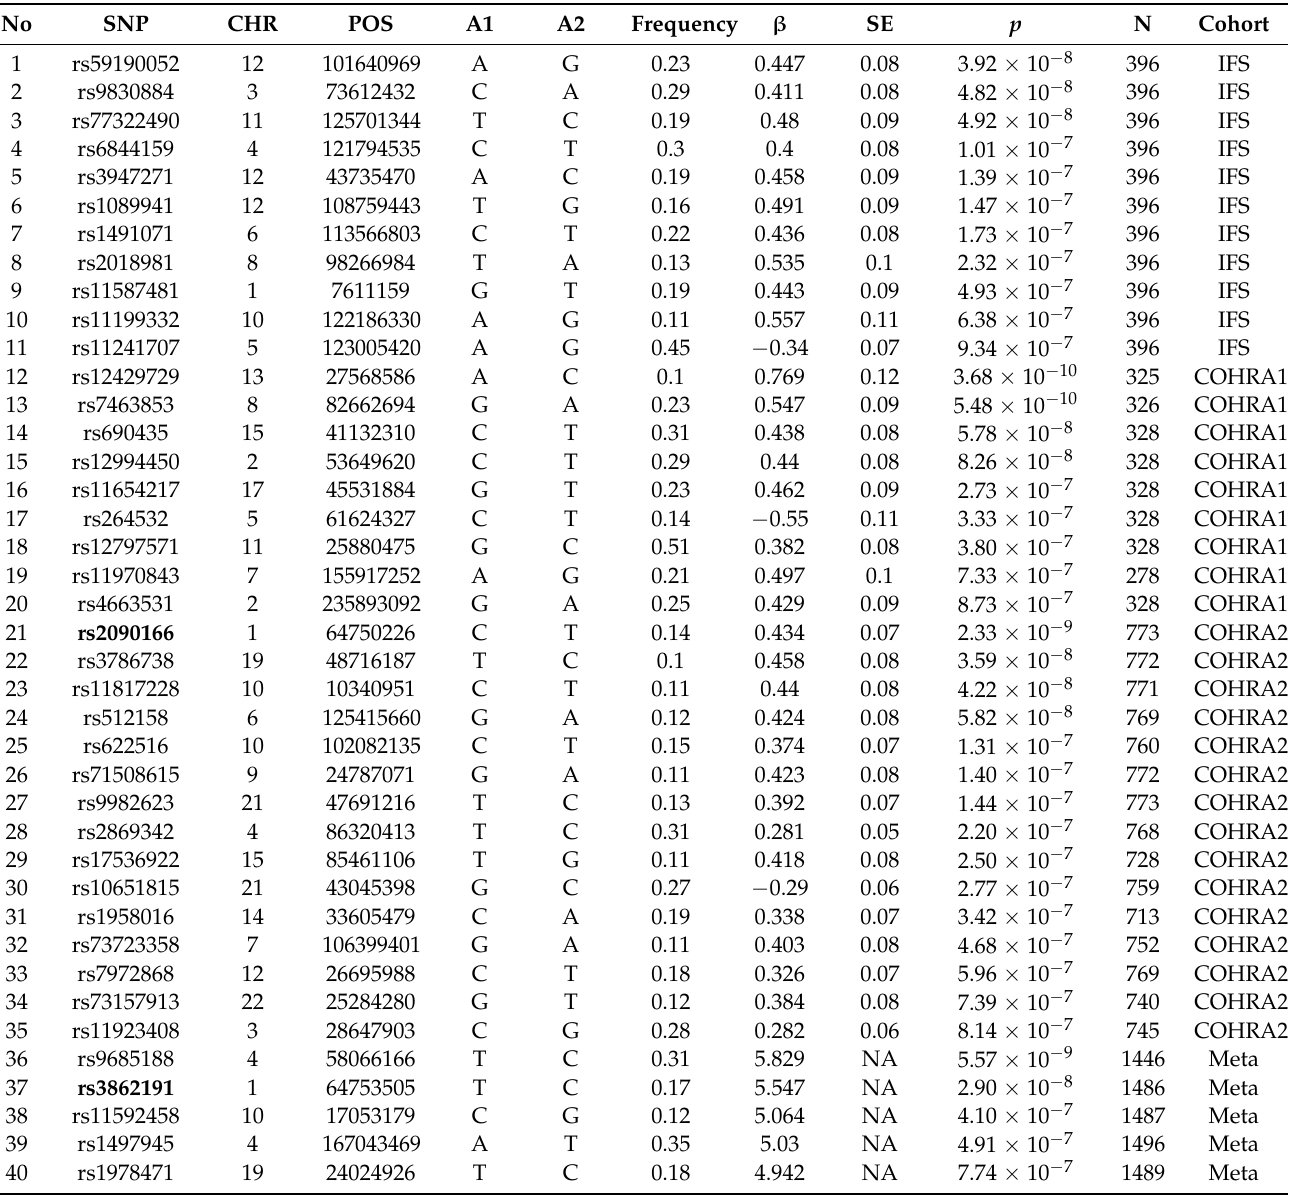
Table 2. 40 prioritized SNPs ( p < 1 × 10 − 6 ) from vQTL of dfs in IFS, COHRA1, COHRA2, and